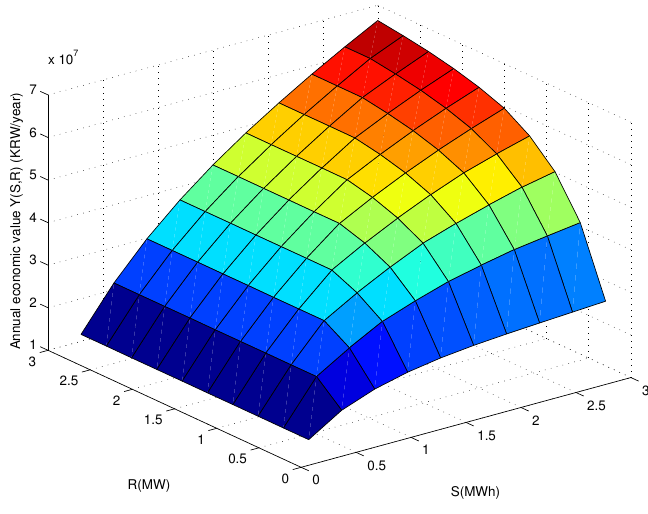
Figure 8. Annual economic values Y ( S , R ) for different storage sizes S and different charging/discharging capacities R